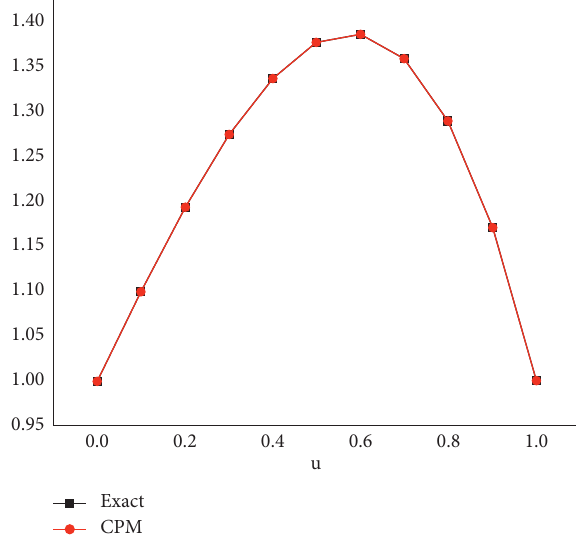
Figure 9: The exact and CPM solution graph for problem 4.